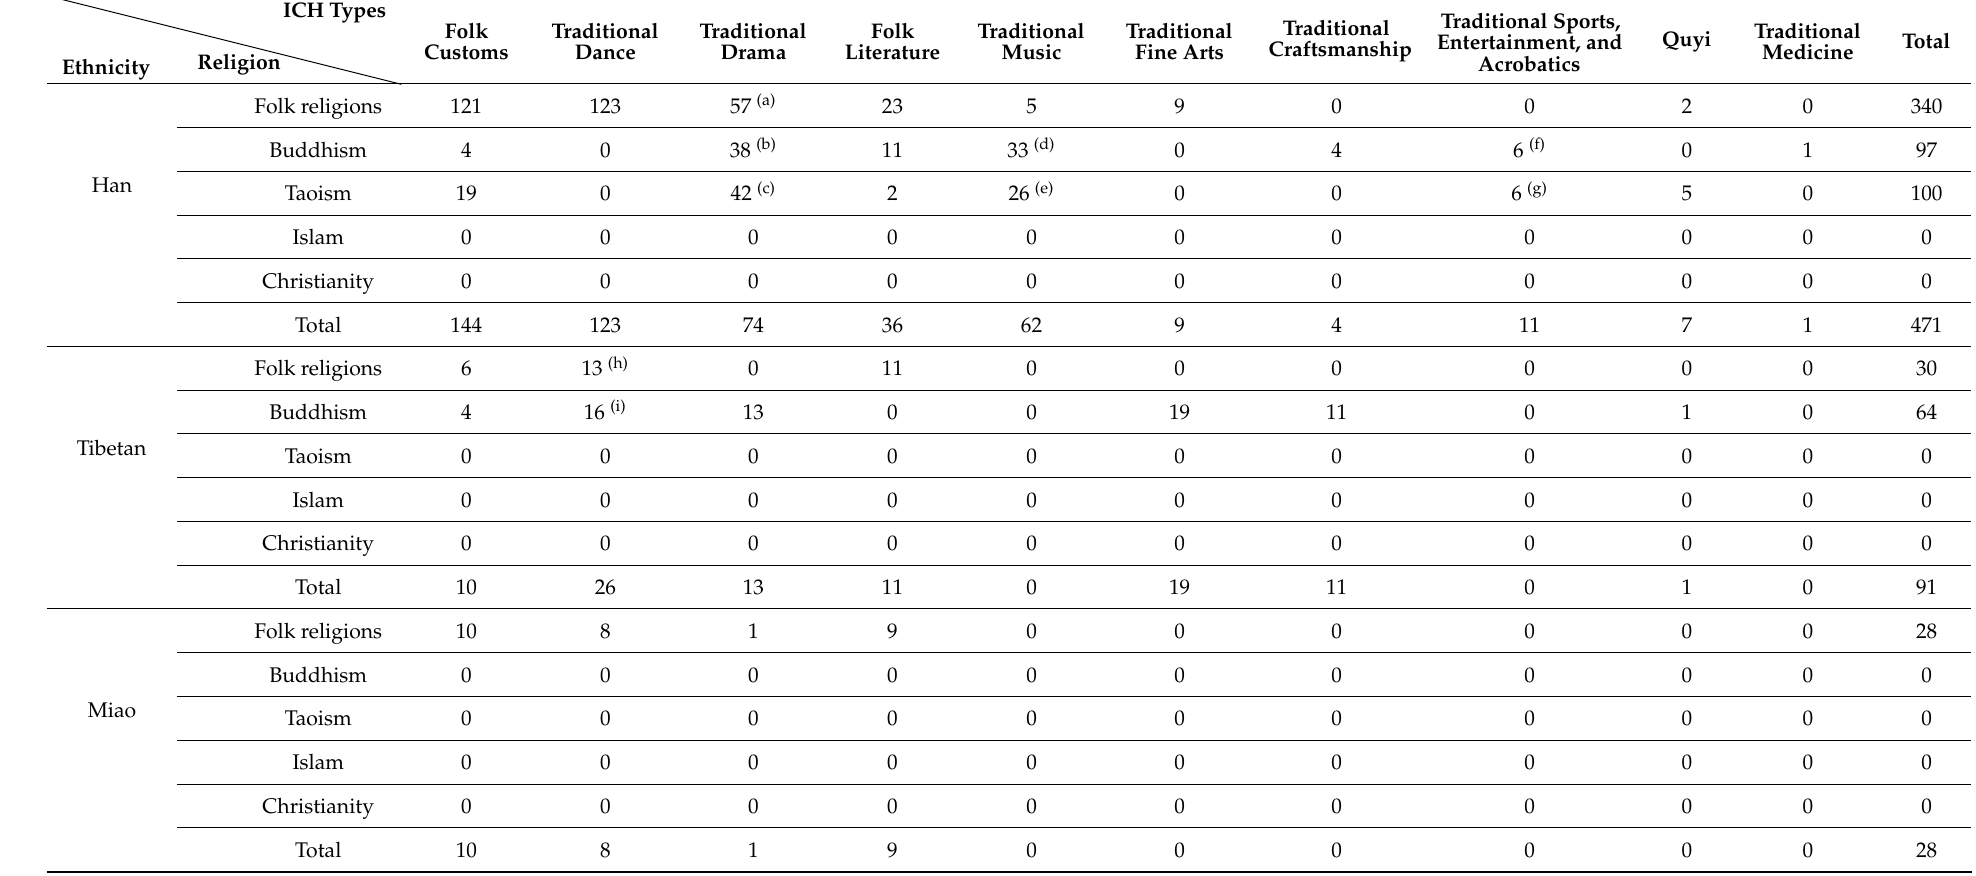
Table 1. Statistics of religion type and ICH categories in the top five nationalities in the proportion of religion-related ICH items.